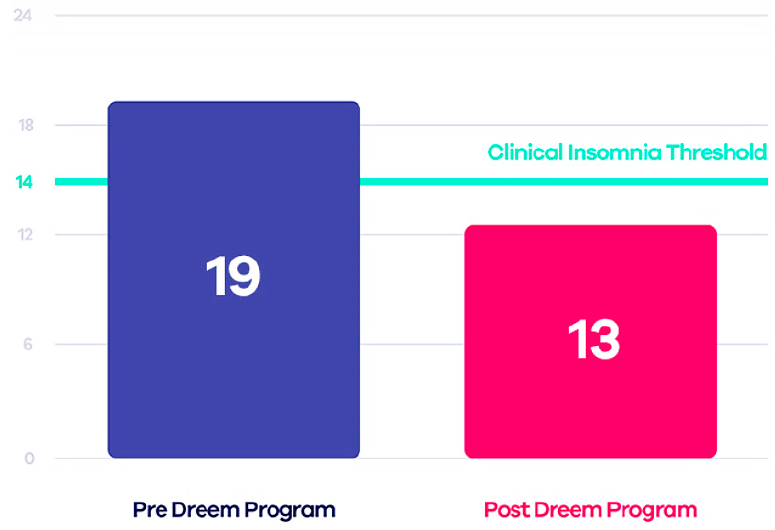
Figure 3. Comparison between ISI scores before and after using Dreem 2 program [55].